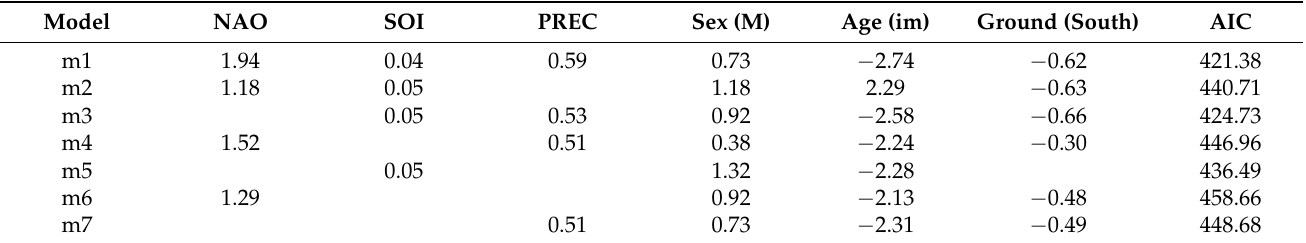
Table 1. The Cox proportional hazards regression for the propensity of spring departures of American white pelicans ( Pelecanus erythrorhynchos ) from the non-breeding grounds in the Gulf of Mexico from 2002 to